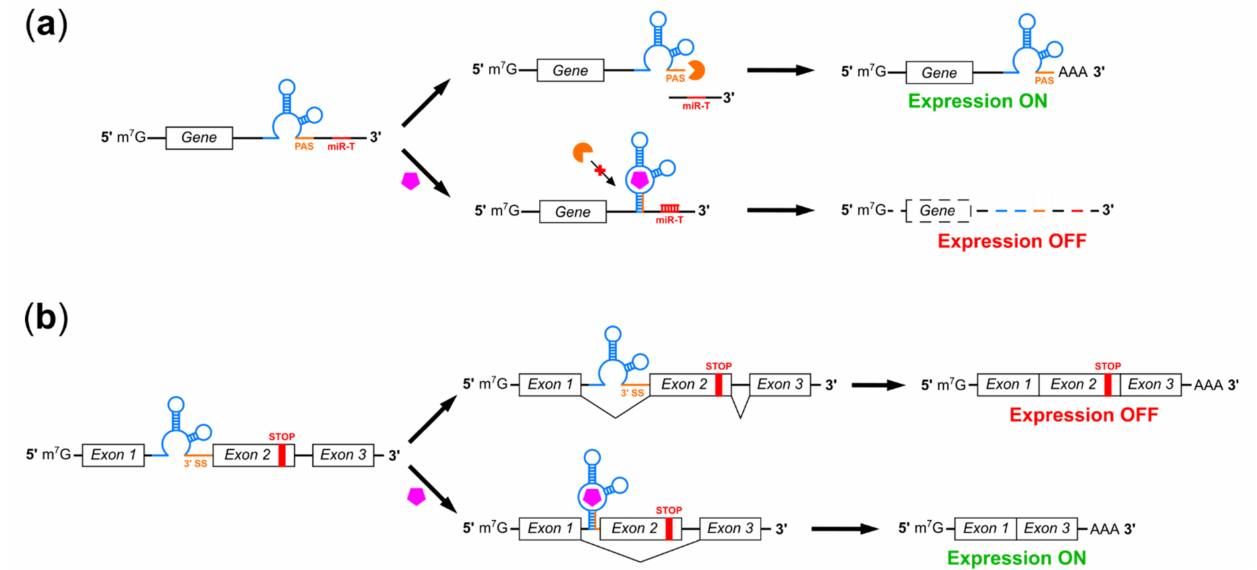
Figure 1. Riboswitch Regulation of mRNA Processing in Mammalian Cells. ( a ) Regulation of polyadenylation. In the absence of ligand, the polyadenylation site (PAS, orange) is bound by the polyadenylation complex (orange), which removes a downstream miRNA target site (miR-T, red) and adds a poly-A tail to enable expression. Ligand binding (purple) to an aptamer domain (blue) sequesters the PAS, blocking processing and promoting mRNA degradation by exonucleases and miRNA-induced silencing [66]. ( b ) Regulation of splicing by ligand-induced exon skipping. In the absence of ligand binding, an exon with a premature stop codon is spliced into the mRNA, preventing gene expression. Ligand binding sequesters spliceosome recognition elements such as the 3 (cid:48) acceptor site (3 (cid:48) SS, orange), promoting exon skipping and expression of a full-length, functional protein